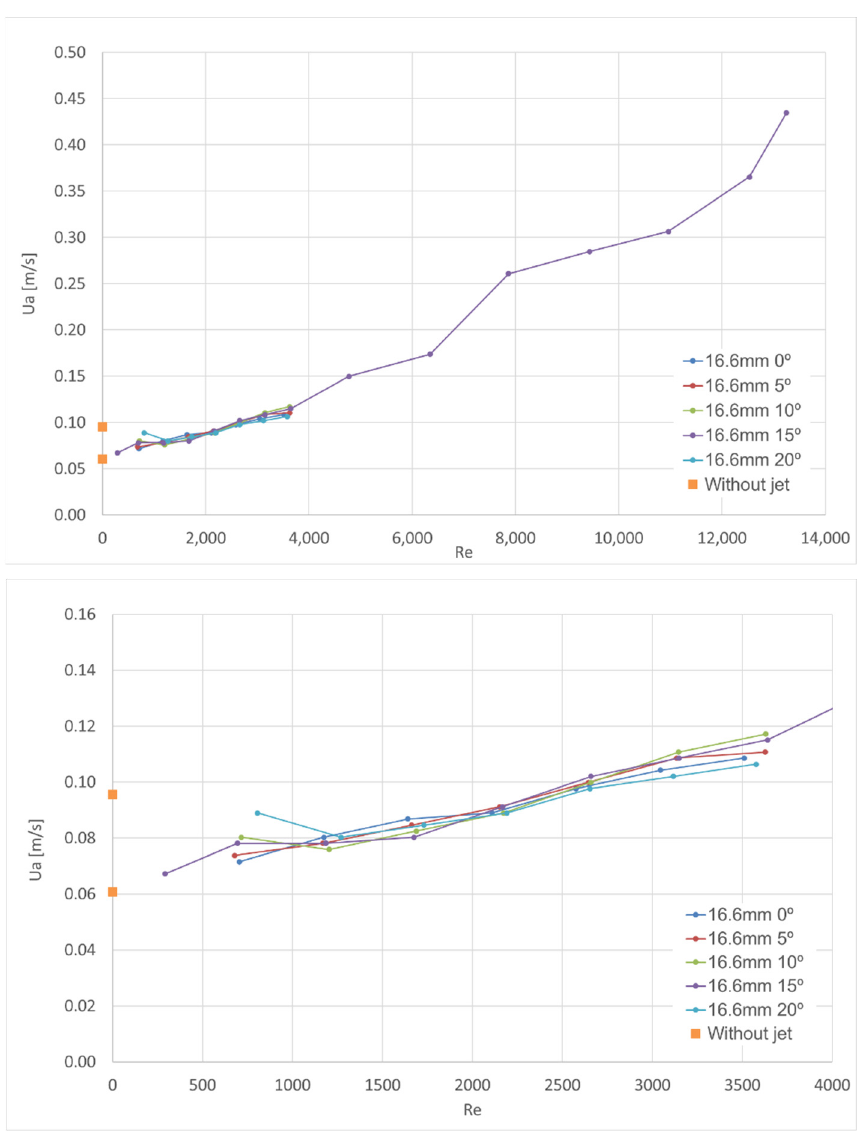
Figure 7. Test results for visual aerodynamic sealing of the air curtain for the nominal nozzle thick- ness of 10 mm.